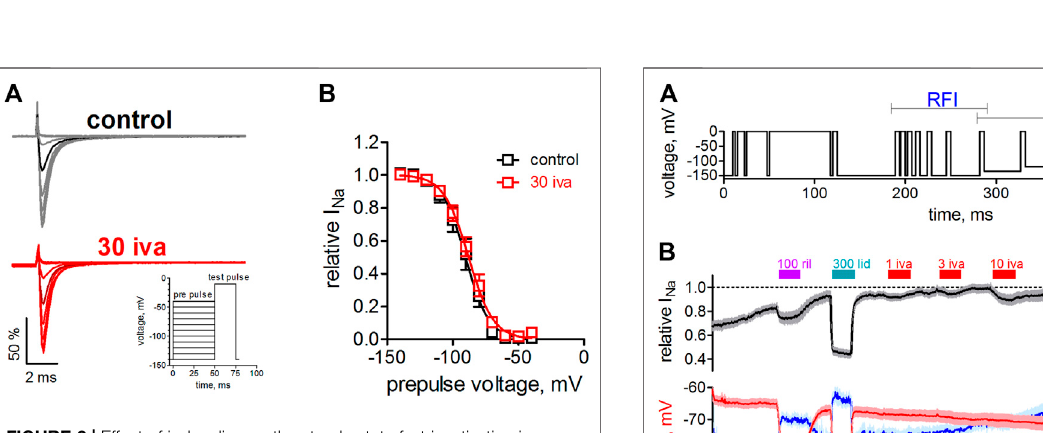
FIGURE 2 | Effect of ivabradine on the steady-state fast inactivation in human Na v 1.5 channels. (A) Voltage-clamp protocol and original current traces in the presence and absence of 30 µM ivabradine. tsA-201 cells expressing human Na v 1.5 channels were held at a holding potential of − 140 mV. An inactivating prepulse of 50 ms to various voltages preceded a 25 ms test pulse to − 10 mV, to maximally activate the available channels (inset). Current traces for a prepulse to − 90 mV are highlighted in a darker color. (B) Voltage-dependence of steady-state fast inactivation as derived from maximal inward current amplitude plotted against prepulse voltages. No signi fi cant difference was found between the half point, V 1/2 = − 90 ± 3 and − 88 ± 2 ( p = 0.6), and the steepness, k = 7.8 ± 0.3 and 8.7 ± 0.4 ( p = 0.12), under control conditions ( n = 6) and in the presence of ivabradine ( n = 7), respectively.